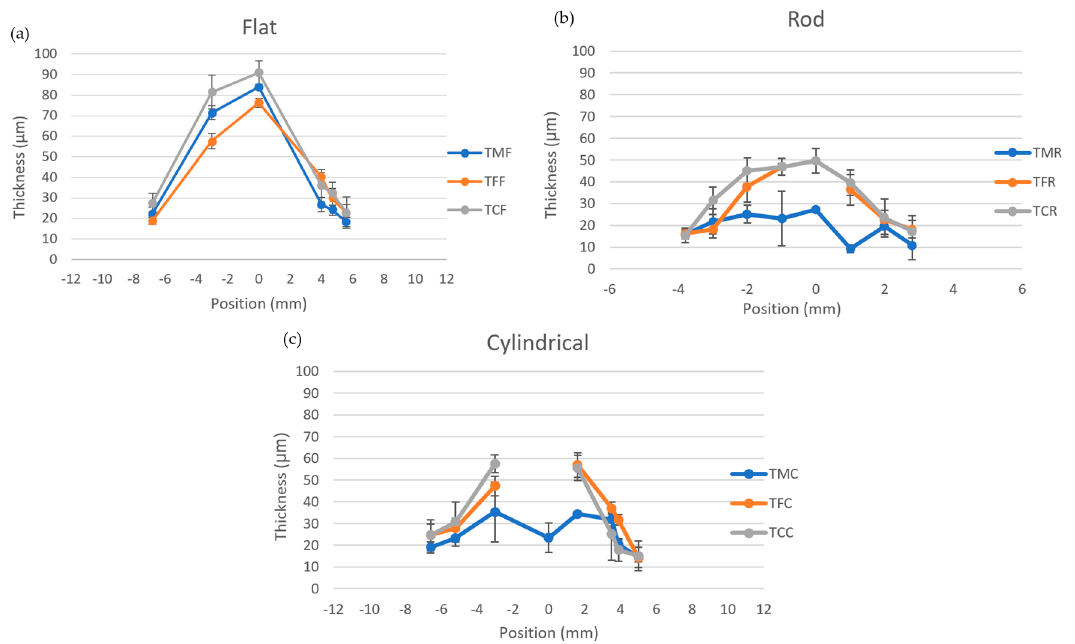
Figure 14. Thickness profiles of coatings with standard deviation: ( a ) flat samples; ( b ) rod samples and ( c ) cylindrical samples.